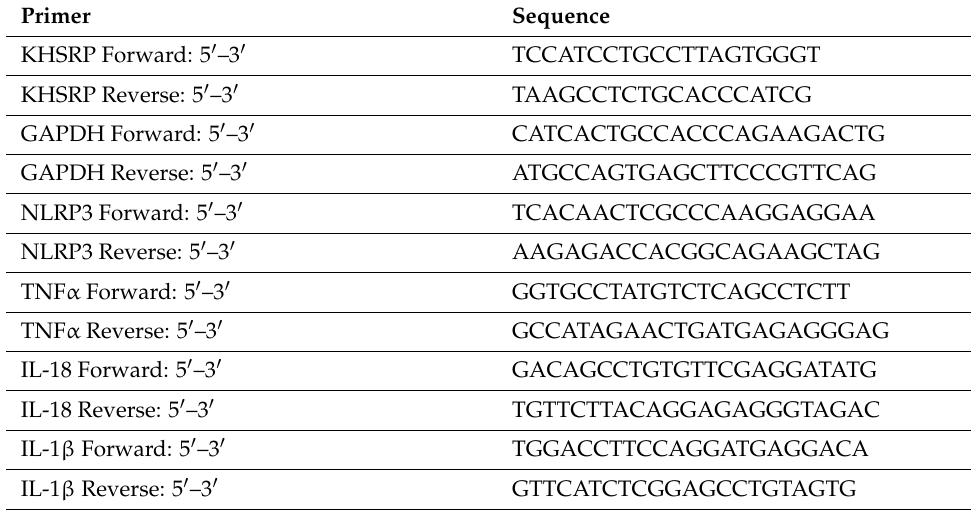
Table 1. RNA sequence for the primers used in